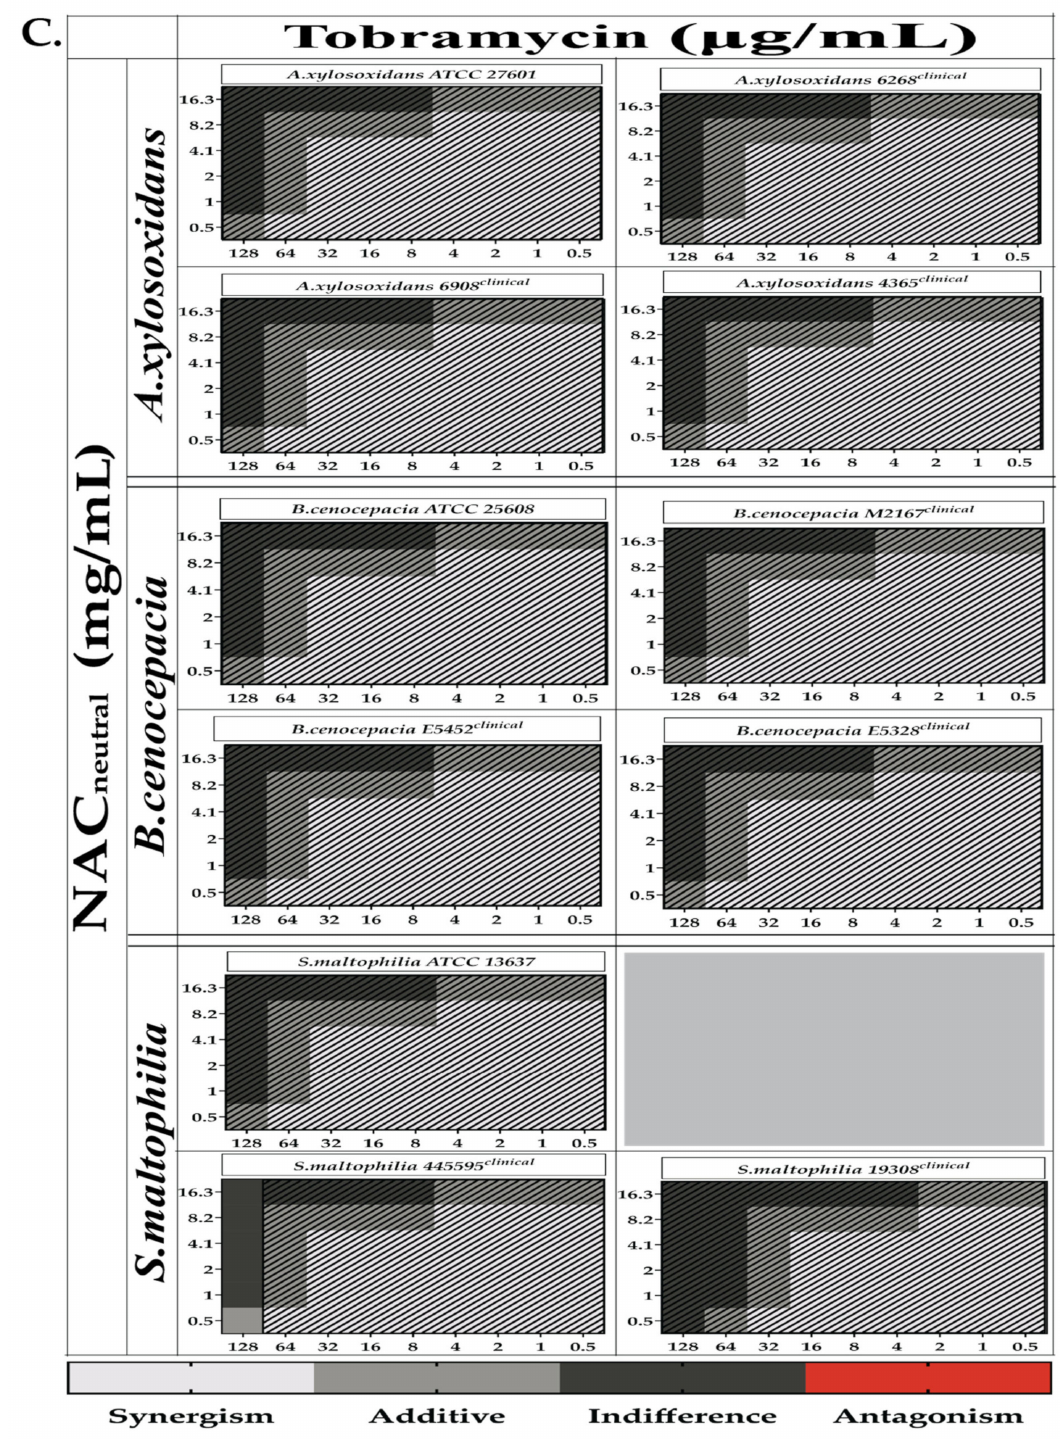
Figure 3. In vitro synergism of NAC neutral /antibiotic combinations against bacterial strains grown in planktonic phase. Heat map representing color-coded fractional inhibitory concentration index (FICI) as calculated from planktonic growth of all bacterial strains of A. xylosoxidans , B. cenocepacia , S. maltophilia against combinations of ( A ) ciprofloxacin, ( B ) colistin and ( C ) tobramycin in combination with NAC neutral . Shaded regions represent areas where combinations were ineffective in killing planktonic bacteria. The bounds of synergy have been set as follows: ≤ 0.5, synergy; 0.5 > FICI ≥ 1, additive; >1–4, indifference; >4,